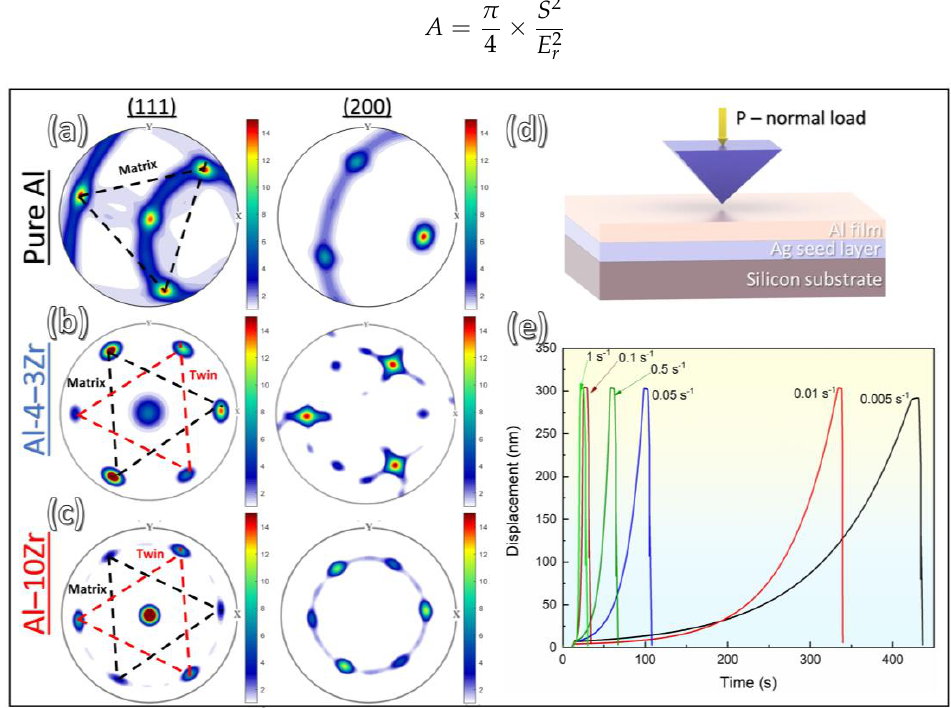
Figure 1. Comparison of (111) and (200) X-ray pole figures among ( a ) pure Al, ( b ) nanotwinned (NT) Al–4.3Zr, and ( c ) NT Al–10Zr, revealing strong (111) textures in all three films. The six-fold symmetry in the Al–Zr alloys indicates twin formation. ( d ) Schematic detailing the nanoindentation test